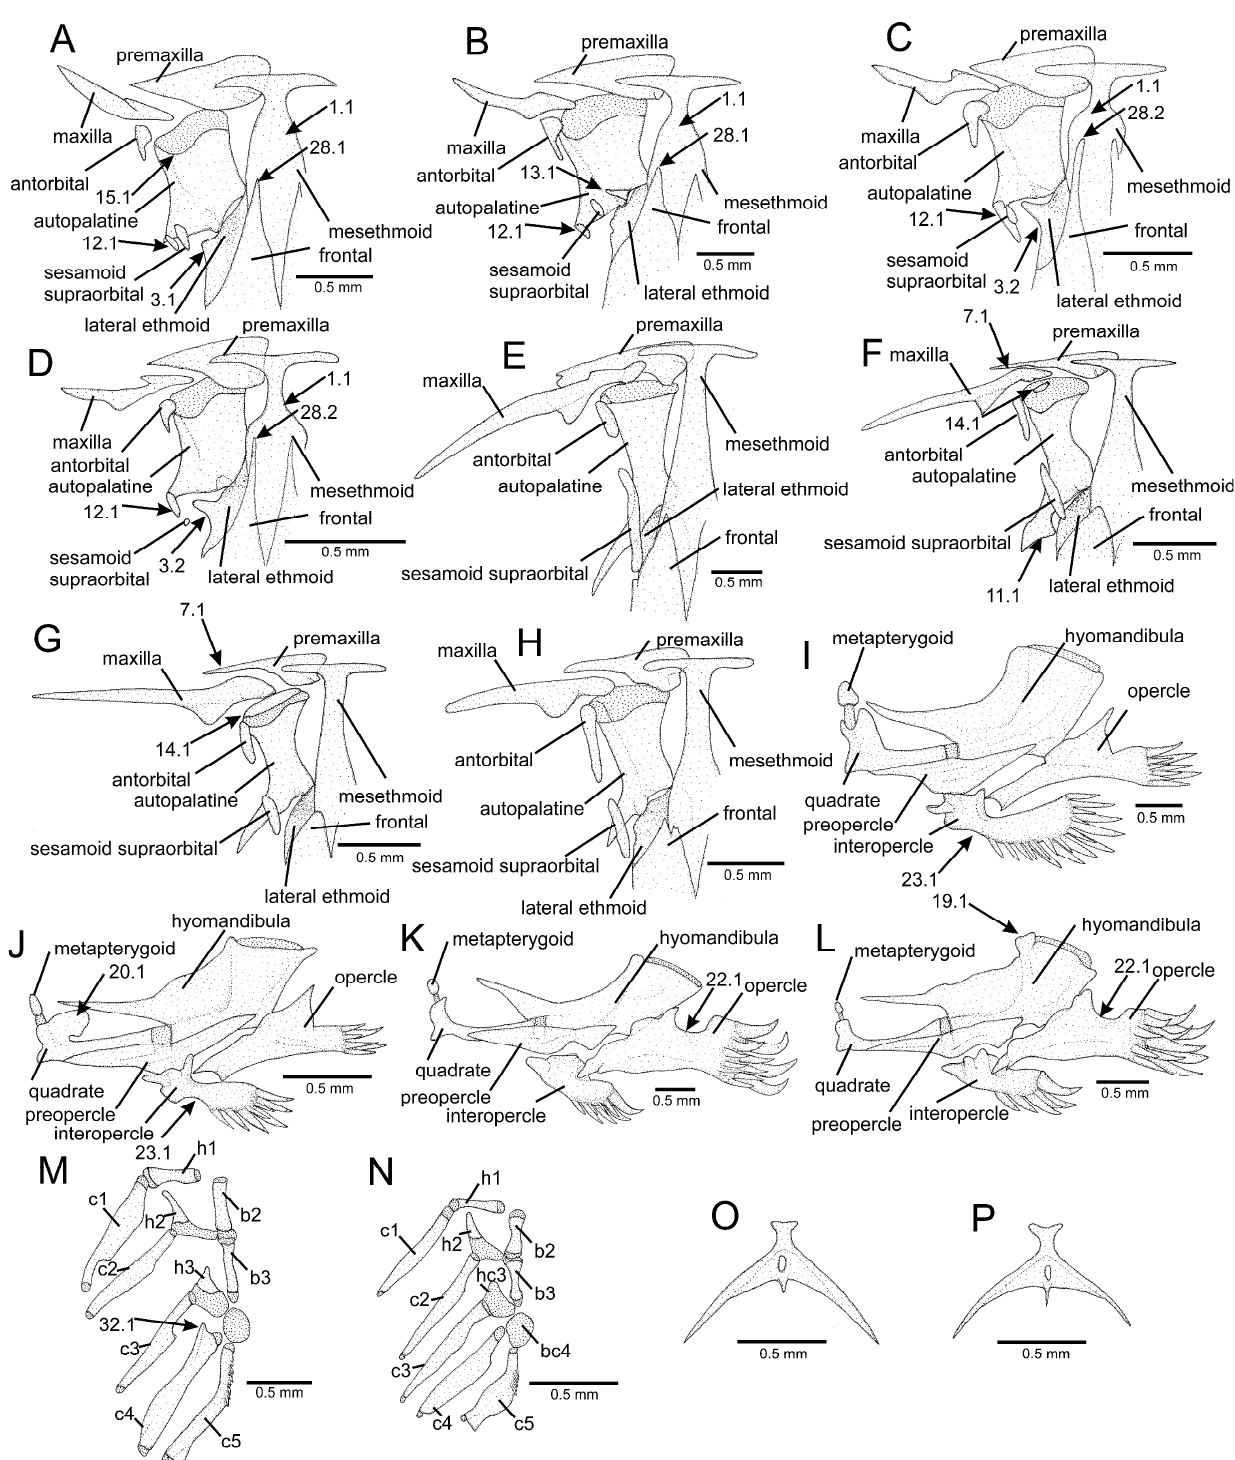
Figure 4. Osteological features in the Microcambevinae: ( A – H ) mesethmoidal region and adjacent bones, middle and left portions, dorsal view; ( I – L ) left jaw suspensorium and opercular series, lateral view; ( M , N ) ventral branchial arch, middle and left portions, dorsal view; ( O – P ), parhypural, ventral view, of: ( A ) Listrura ( Prolistrura ) camposi ; ( B , I ) Listrura ( Paralistrura ) tetraradiata ; ( C , J , N , O ) Listrura ( Listrura ) macacuensis ; ( D , P ) Listrura ( Listrura ) macaensis ; ( E , K ) Microcambeva ( Pterocambeva ) ribeirae ; ( F ) Microcambeva ( Microcambeva ) jucuensis ; ( G ) Microcambeva ( Microcambeva ) barbata ; ( H , L , M ) Microcambeva ( Trichocambeva ) filamentosa . Larger stippling represents cartilages. The numbers are characters, followed by character states after dots, which are numbered according to Appendix C.